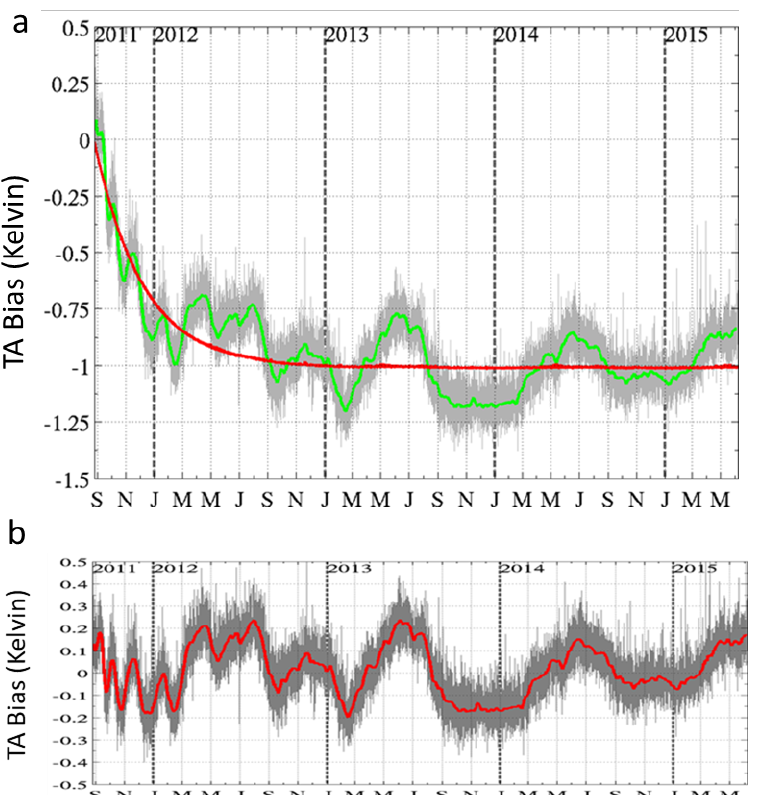
Figure 6. The difference between observed and expected antenna temperature (TA bias) for beam 2 and horizontal polarization ( a ) before and ( b ) after removing an exponential fit for the temporal drift. Grey is the difference per orbit. Green ( a ) and red ( b ) are the average of the difference over a seven-day period (i.e., global average); red ( a ) is an exponential fit to the temporal drift (based on figures in Dinnat et al.